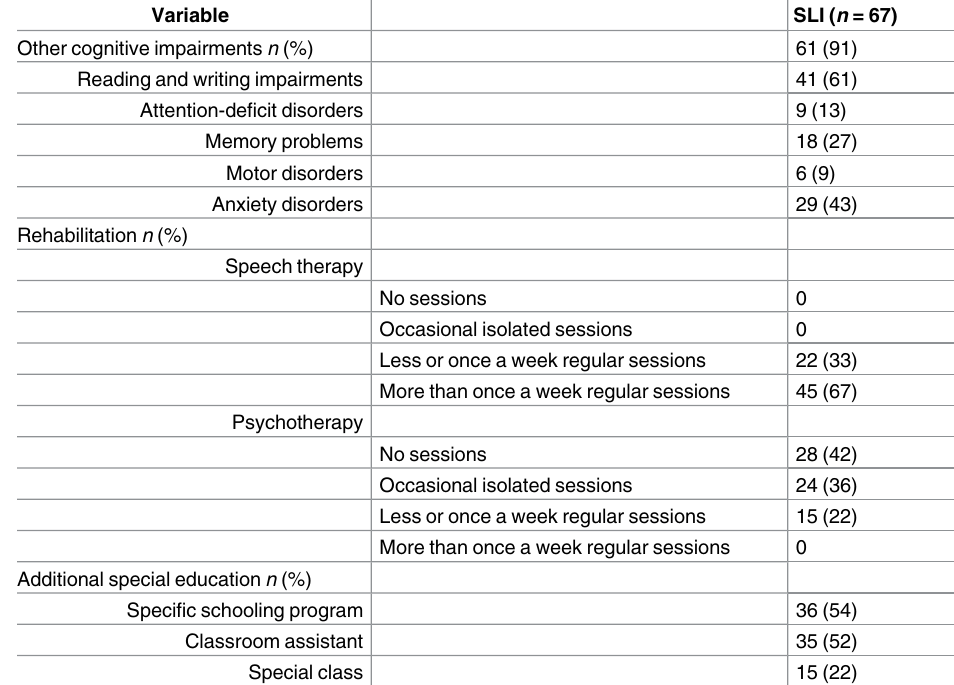
Table 2. Characteristics of the specific language-impairment (SLI) group regarding other cognitive impairments, individual rehabilitation and specific school